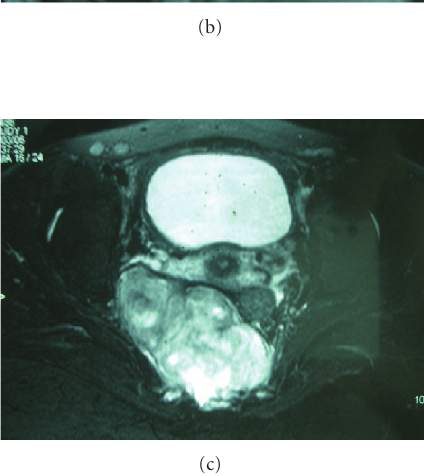
Figure 2: MR examination of pelvis demonstrates bony destruction at sacrum and neural foramen from S1–S4 levels with soft tissue mass formation. This mass appears as low signal intensity on sagittal T1-weighted MR image (Figure 2(a)), heterogeneous increased signal intensity on sagittal and axial T2-weighted MR image (Figures 2(b) and 2(c)). Tumor extended and displaced uterus and urinary bladder anteriorly, but not invaded, evidenced by fat plane (arrows).